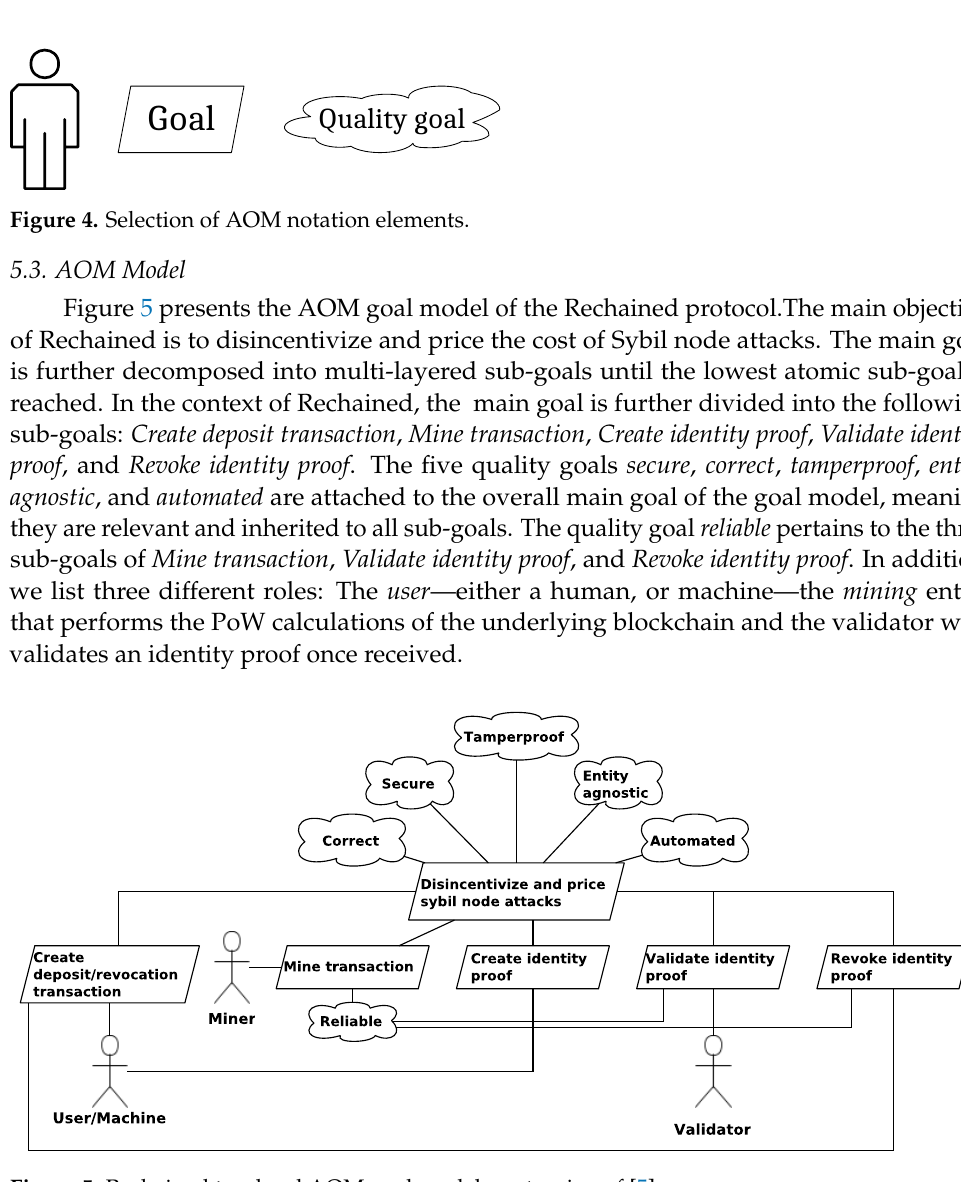
Figure 5. Rechained top-level AOM goal model—extension of